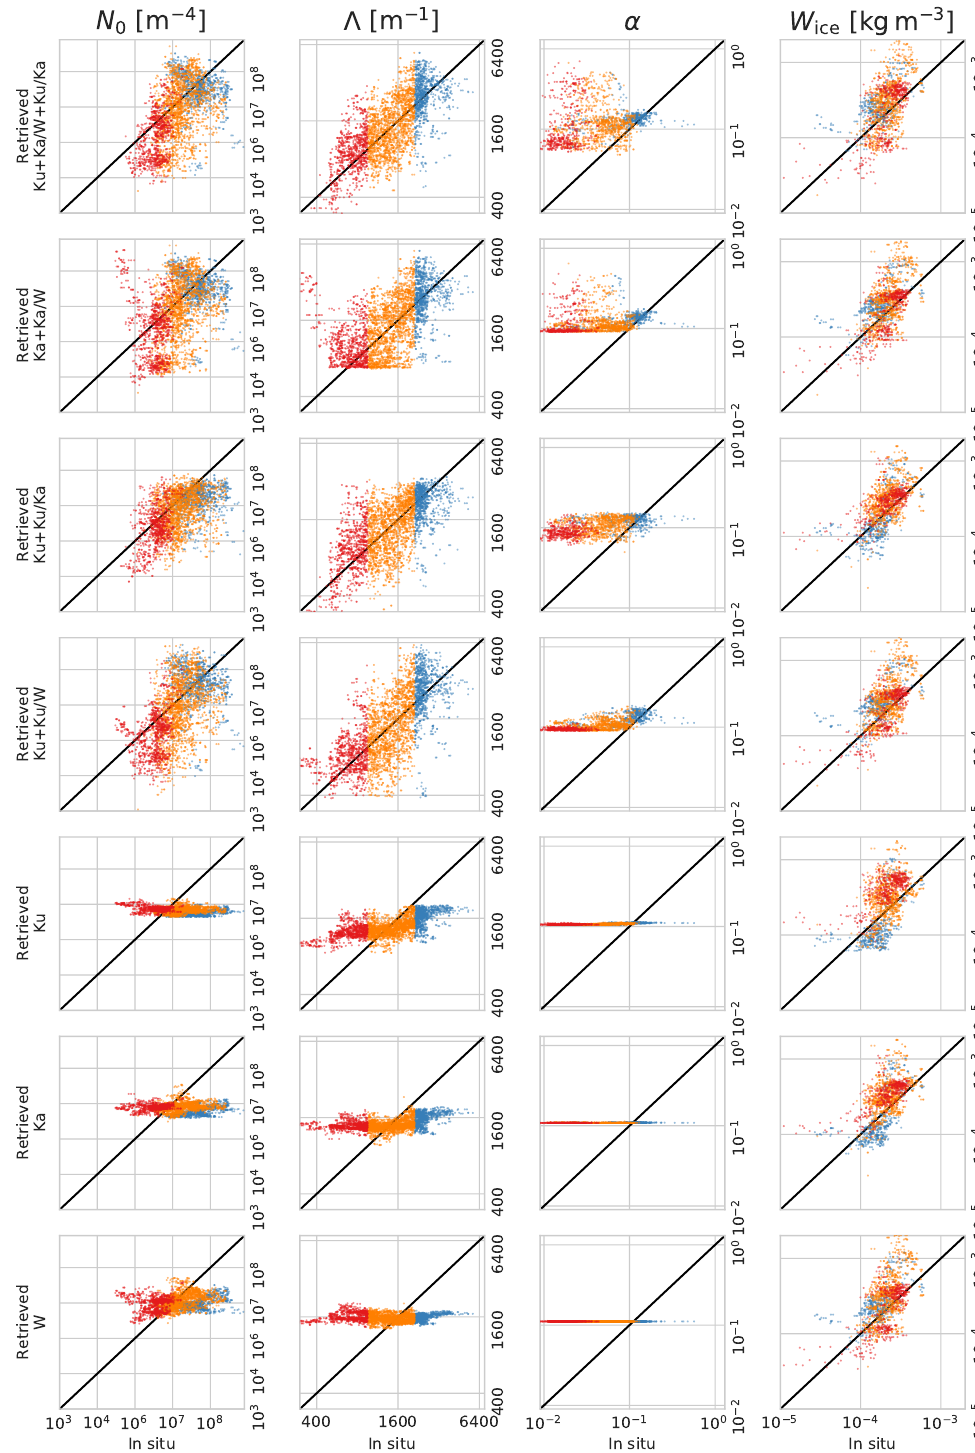
Figure 4. Scatter plots of in situ measured (horizontal axis) and retrieved (vertical axis) microphysical values from the collocated Citation– APR-3 dataset. The columns correspond to different microphysical parameters: from left to right, the intercept parameter N 0 , the slope parameter (cid:51) , the mass–dimensional prefactor α and the ice water content W ice . The rows correspond to different combinations of radar frequencies and DWRs used to run the retrieval, as shown to the left of each row. The color denotes the size of the snowflakes: blue dots correspond to small particles (largest 25% of (cid:51) ), orange to medium-sized particles and red to large particles (smallest 25% of (cid:51) ). In each plot, the black line is the 1 : 1 line. Note the logarithmic scales on the